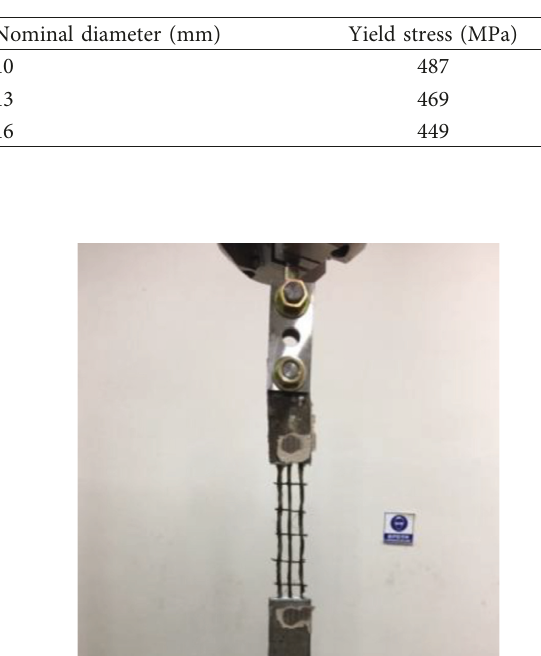
Table 2: Material properties of the used steel.